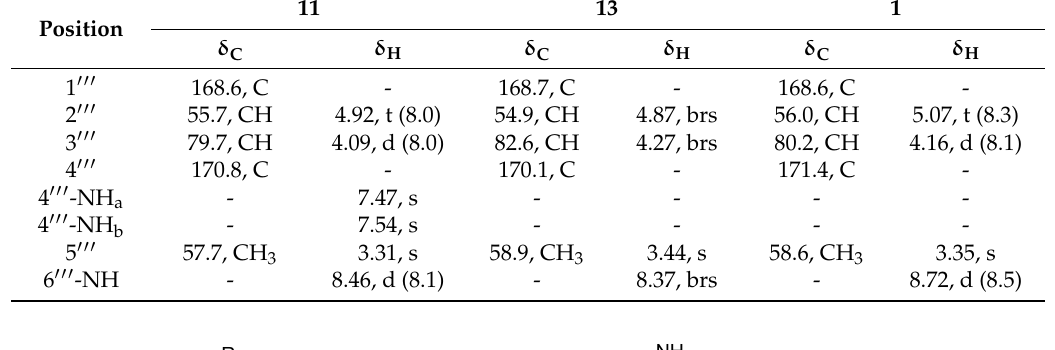
Table 3. Comparison of the NMR data of the β -methoxyasparagine moiety of 1 with those of 11 and 13 (DMSO- d 6 ) .